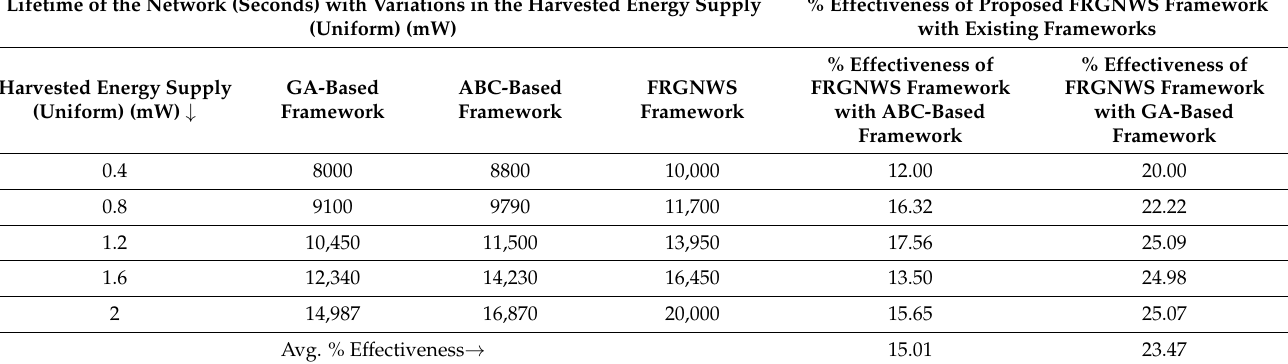
Table 11. The average % effectiveness of the proposed novel framework for the lifetime of network metric with variations in the harvested energy supply (uniformly).